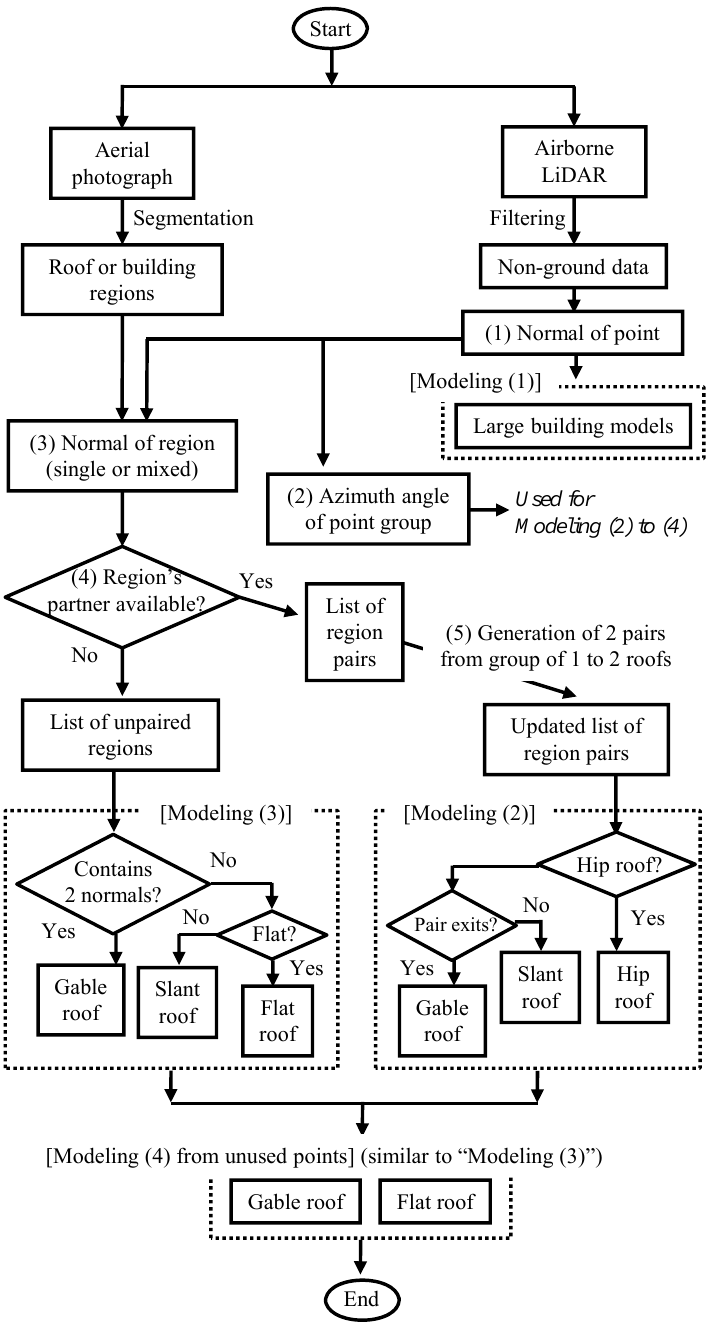
Figure 1. Flowchart of proposed algorithm to generate building